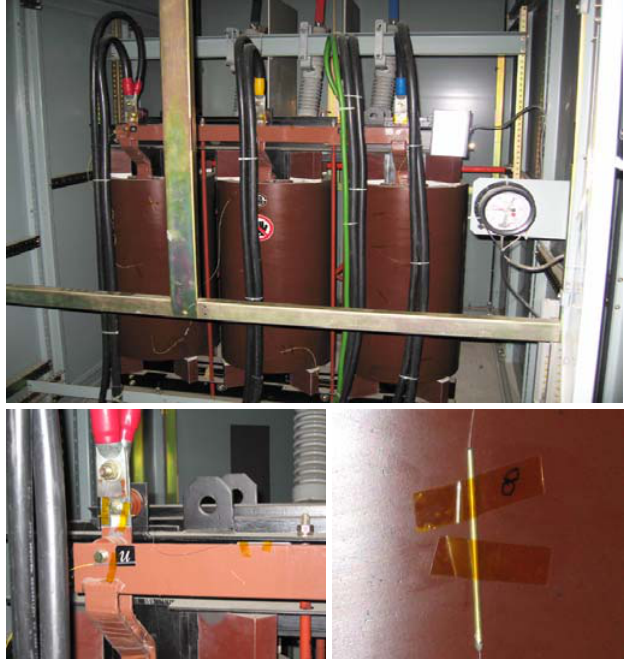
Figure 1. Application of FBG temperature sensors to high-voltage mold type